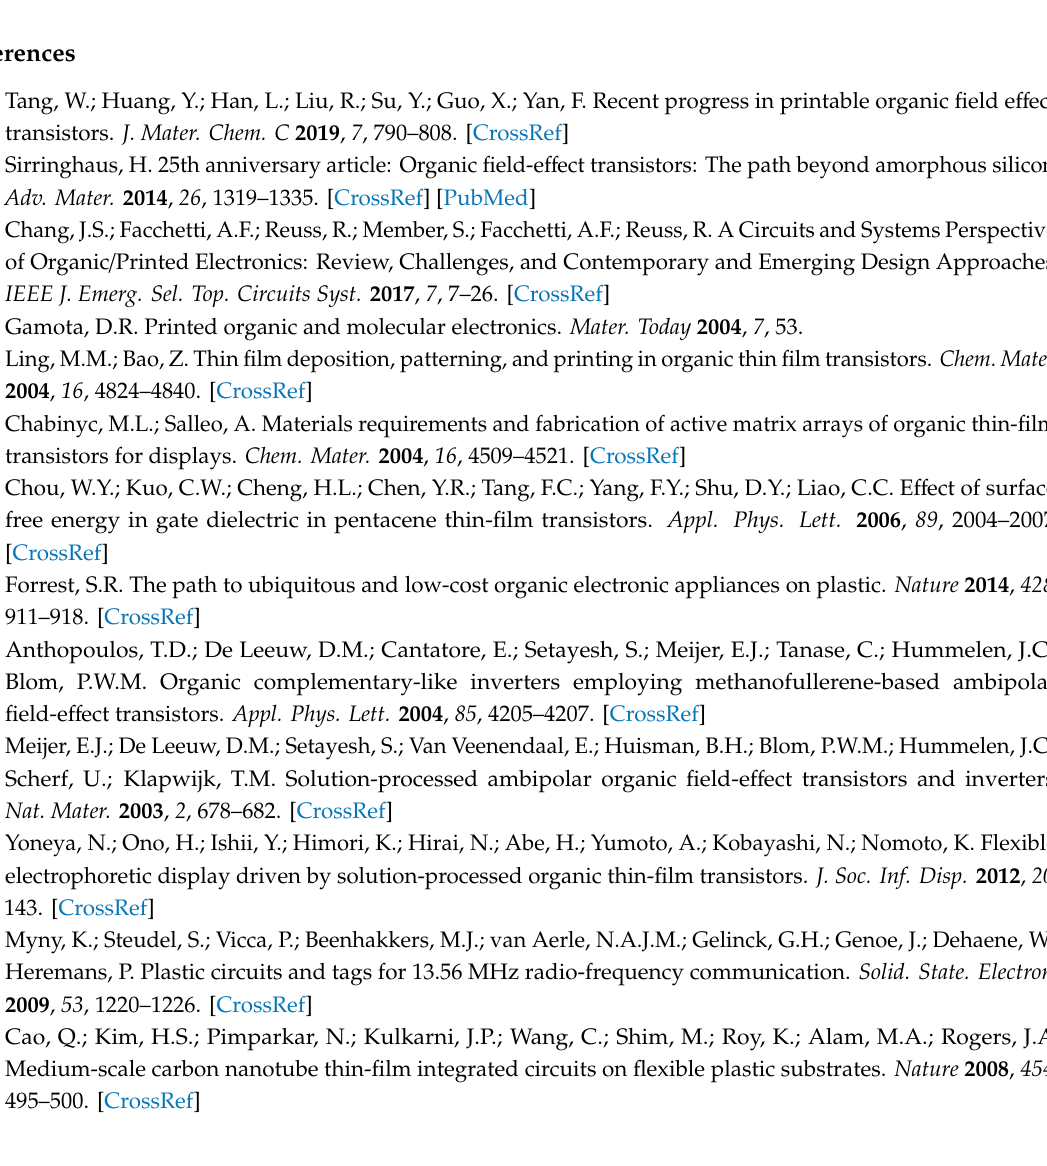
Figure S1: Molecule structures of the small molecule organic semiconductor and the high-k polymer semiconductor binder used for the blend. Figure S2: Square root and logarithmic scale transfer curves of both geometries types for the two behavior of the transistors: (a) Lineal region, and (b) saturation region including the threshold voltage extraction procedure representation. Figure S3: Experimental transfer characteristics for Corbino and interdigitated geometries normalized to channel dimension (CD) for V DS = − 2 V. Figure S4: Experimental output characteristics of interdigitated geometry devices where gate voltage ( V GS ) were swept by − 10 V from − 30 V to 10 V. The channel length is 10 µ m. Figure S5: Output characteristics of the Corbino TFT for the two drain-bias conditions: (a) The inner circle as source and outer ring as drain; and (b) the inner circle as drain and outer ring as source. Figure S6: Turn on voltage of both geometries from the curve transfer curve with V DS = − 20 V. The central mark represents the median, box limits indicate the 25th and 75th percentiles, and whiskers extend to 5th and 9th